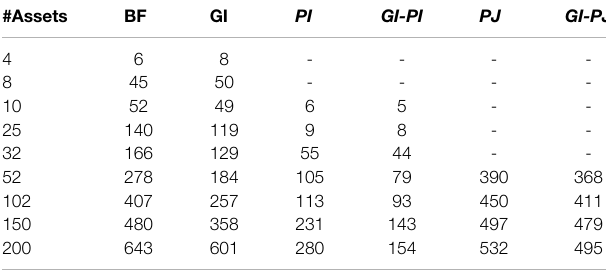
TABLE 3 | Average speed of calculations (in seconds) for methods: BF, Brute Force; GI, Gradual Increase ; PI, Partial Integrality; GI-PI, Combination of Gradual Increase and Partial Integrality; PJ, Proximal Jacobian ADMM; GI-PJ, Combination of Gradual Increase and Proximal Jacobiand